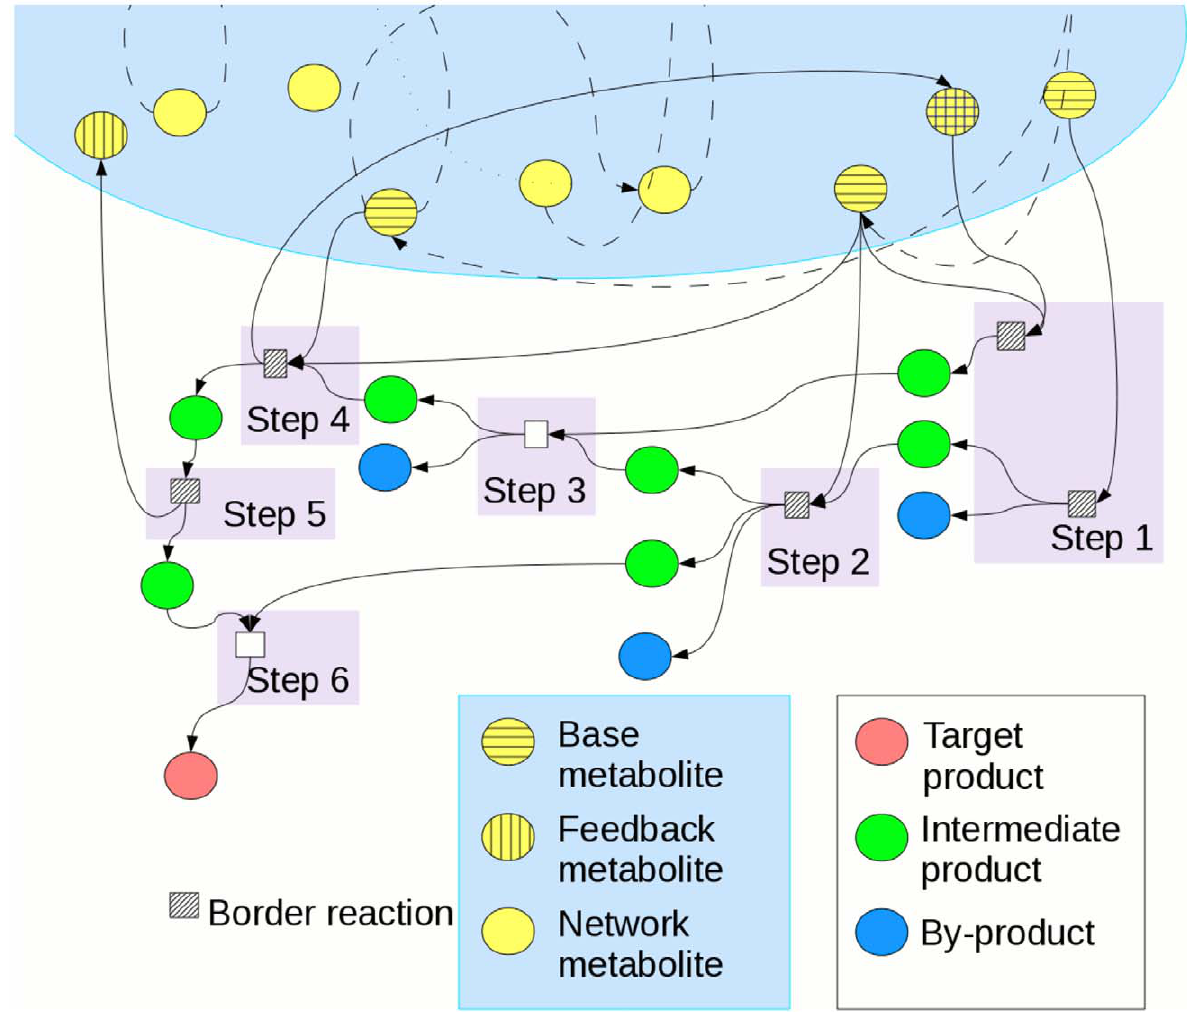
Figure 4. Diagram of a new pathway added to the metabolic network of the organism. The diagram explains different types of metabolites and reactions. Reactions (squares) in the added pathway use base substrates (yellow circles with horizontal shading) from the metabolic core of the organism (light blue area) to produce the target metabolite (the red circle). Added pathway generates intermediate products (green circles) as well as byproducts that are not further converted to the target (blue circles). Products of some reactions feed back into the metabolic core (yellow circles with vertical shading). Reactions are labeled with expansion steps at which they were added to the pathway.